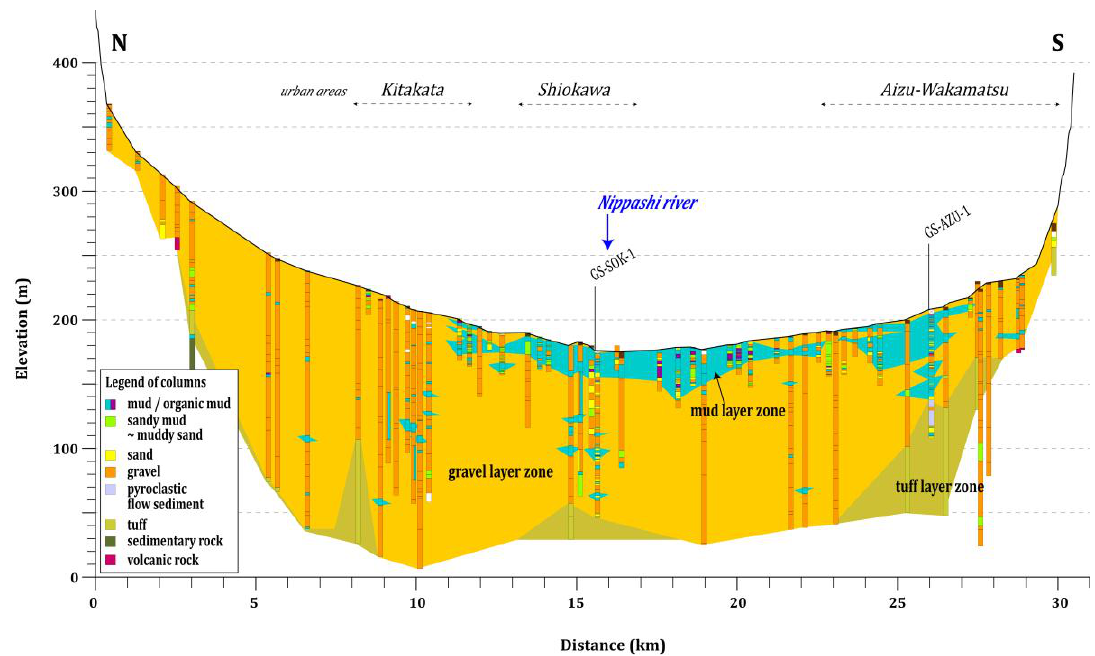
Figure 3. N-S cross section shown in Figure 1b. Columns show sedimentary cores, boring, and snow melting well logs.